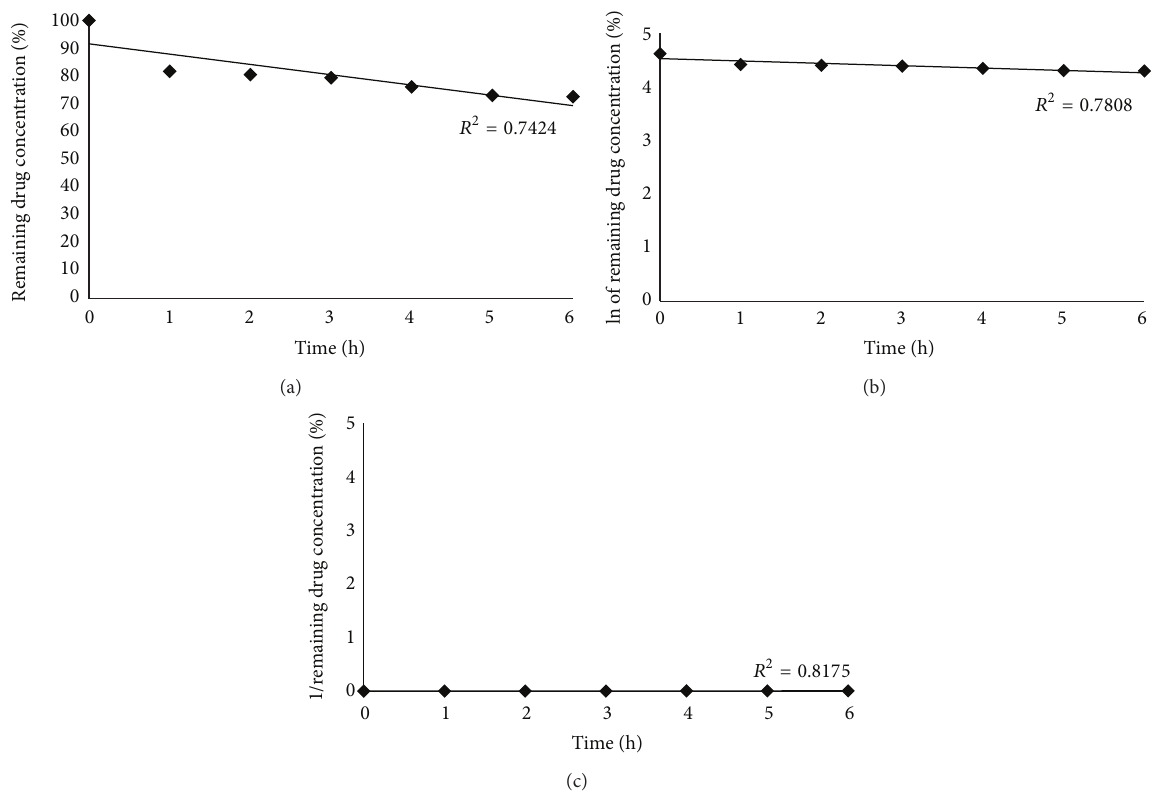
Figure 6: Plots of remaining FA concentration versus time for zero order (a), first order (b), and second order (c) equations.